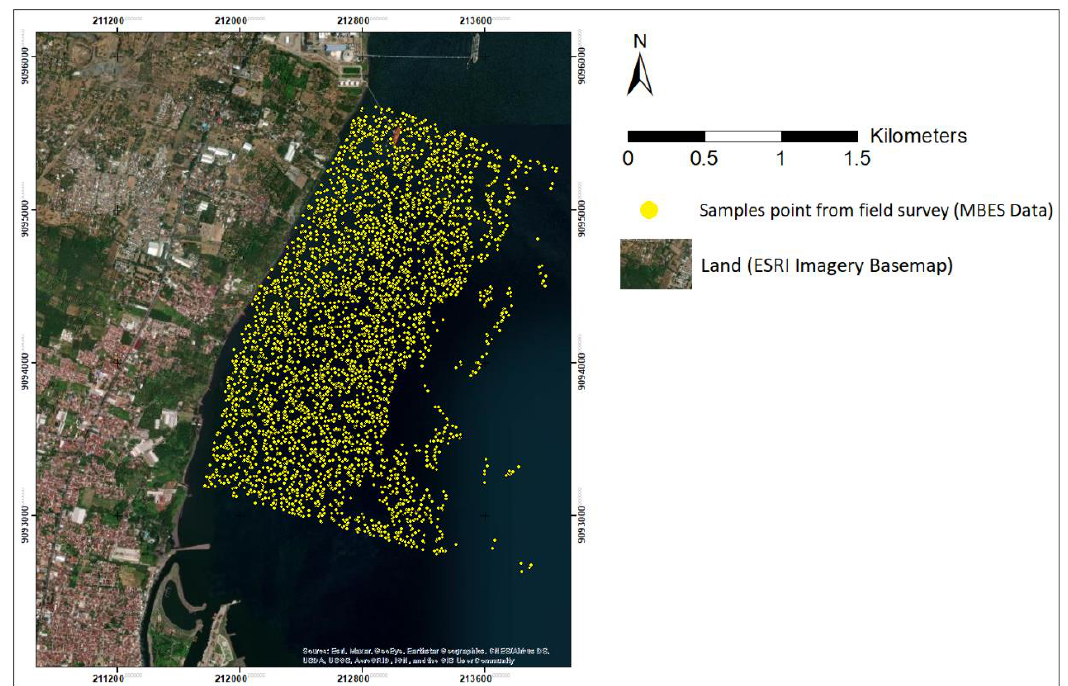
Figure 4 . The Points Distribution of Test